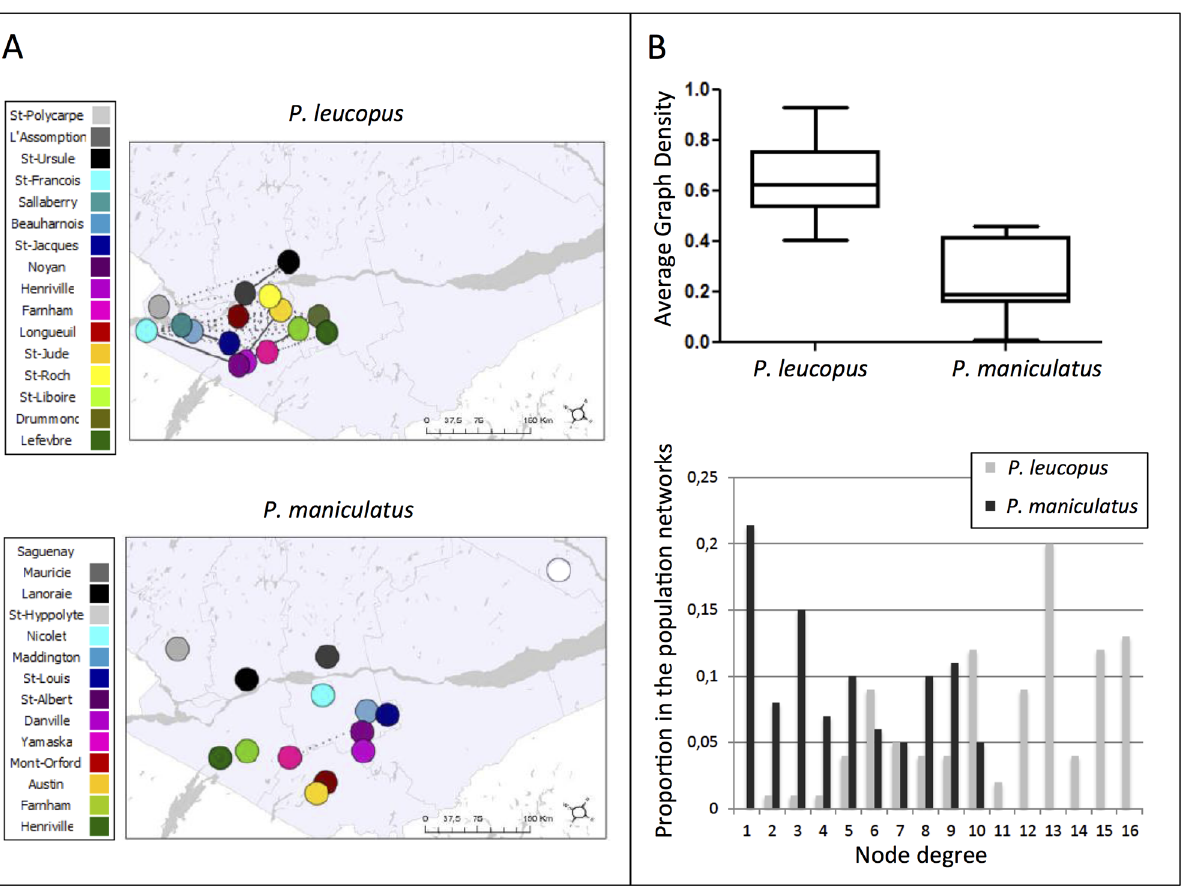
Fig 4. (A) Population networks using the combined sequences of 5 mtDNA regions for P . leucopus and P . maniculatus ; (B) Associated statistics. The colors in the networks correspond to different localities where P . maniculatus and P . leucopus were sampled. Dotted lines correspond to connection probabilities lower than 0.2 while solid lines represent connection probabilities of 0.2 and higher. For both P . leucopus and P . maniculatus , we displayed the average graph density and the average node degree distribution for the five markers in the population